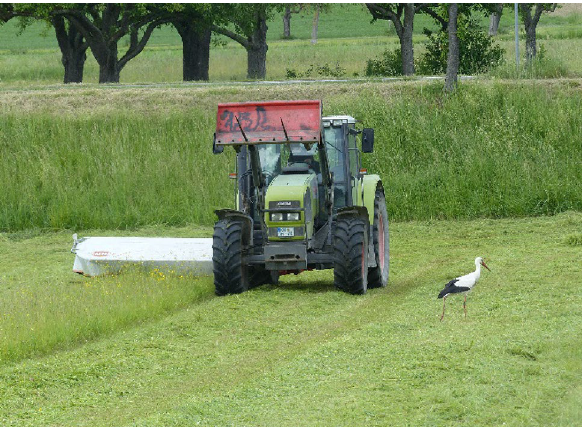
Figure 1. A typical observation of European white stork next to a farmer mowing tall grass. Storks use this association with humans to forage for insects or rodents and other vertebrates disturbed by farming activities. However, farmers are not always approached by storks when mowing. Photo by Christian Ziegler,